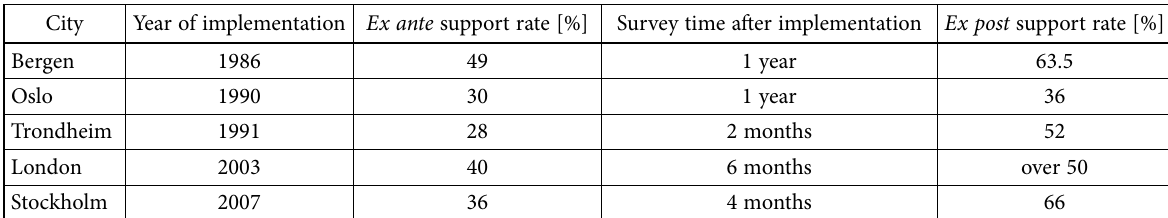
Table 8. Change of public support rate after implementations (Hensher, Li 2013)